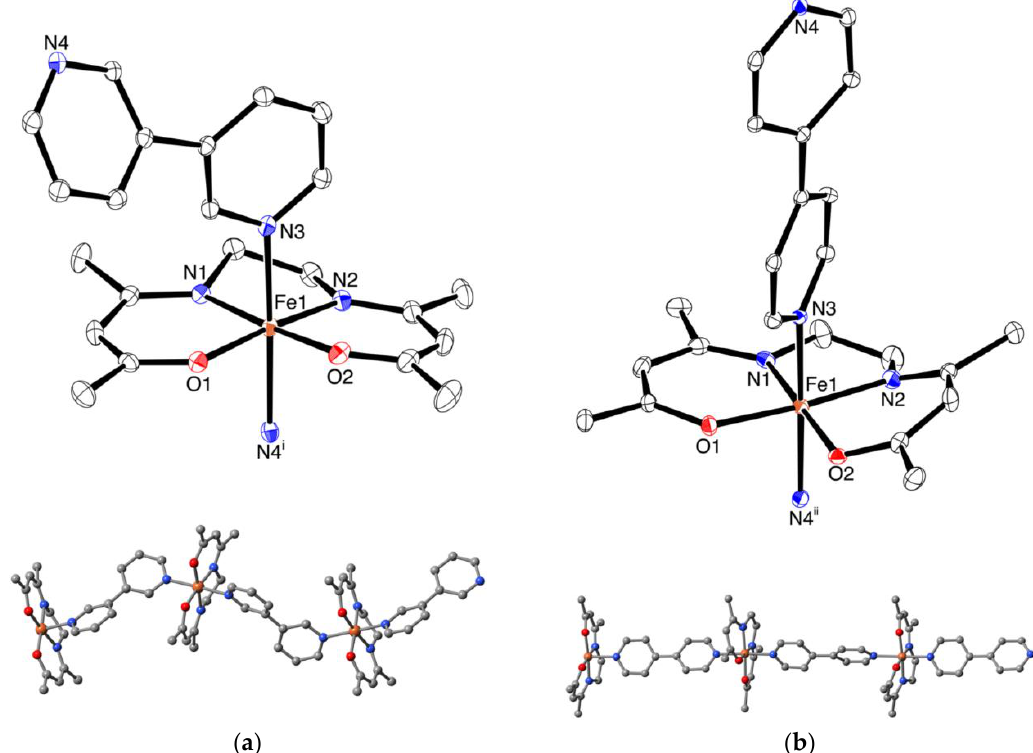
Figure 1. Solid-state molecular structures at 100 K with thermal ellipsoids drawn at 30% probability level (upper), showing numbering schemes for central metal and coordinating atoms only, where symmetry codes: (i) and (ii) x , − y + 3 / 2, z − 1 / 2 and their 1D chain arrangements (lower) for ( a ) 1 and ( b ) 2 . Orange, gray, blue, and red spheres represent Fe, C, N, and O atoms. H atoms are omitted for clarity. Table 1. Selected bond distances (Å ) and angles (°) 1 for 1 and 2 at 100 and 300 K.